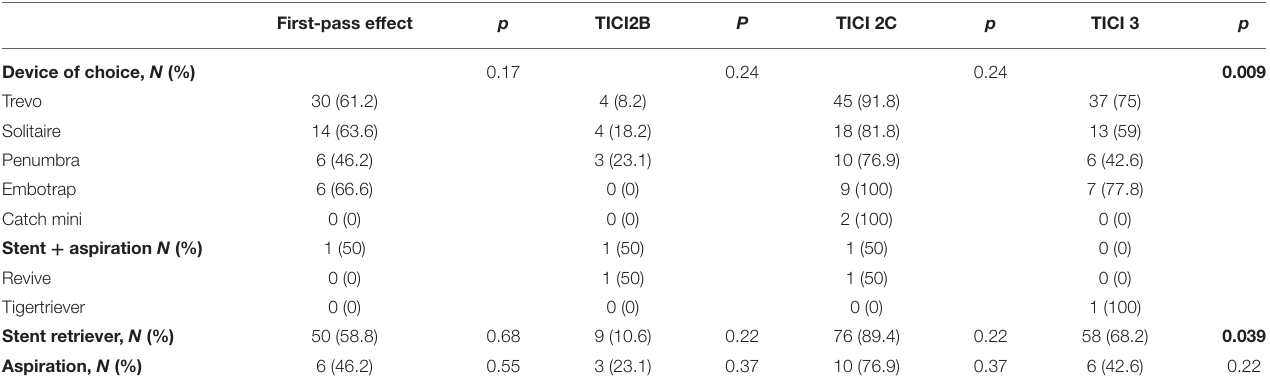
TABLE 3 | Distribution of first-line devices in patients with fibrin-predominant clot (FPC).